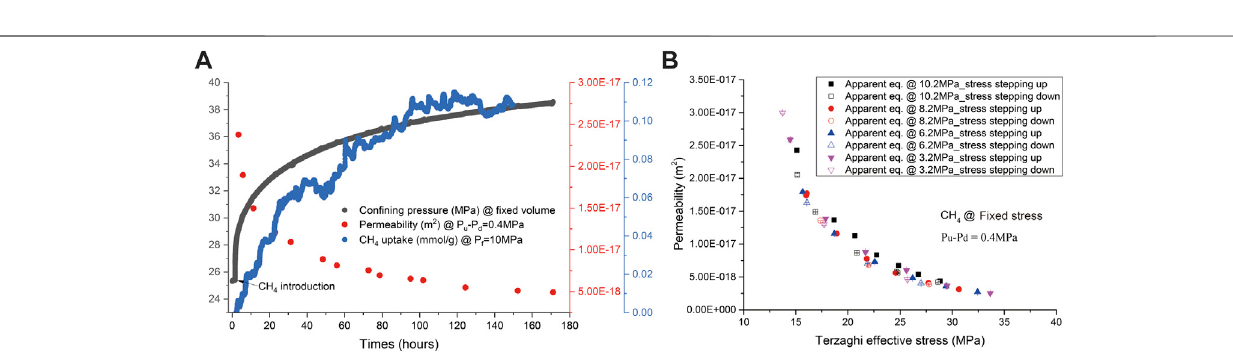
Frontiers in Earth Science |